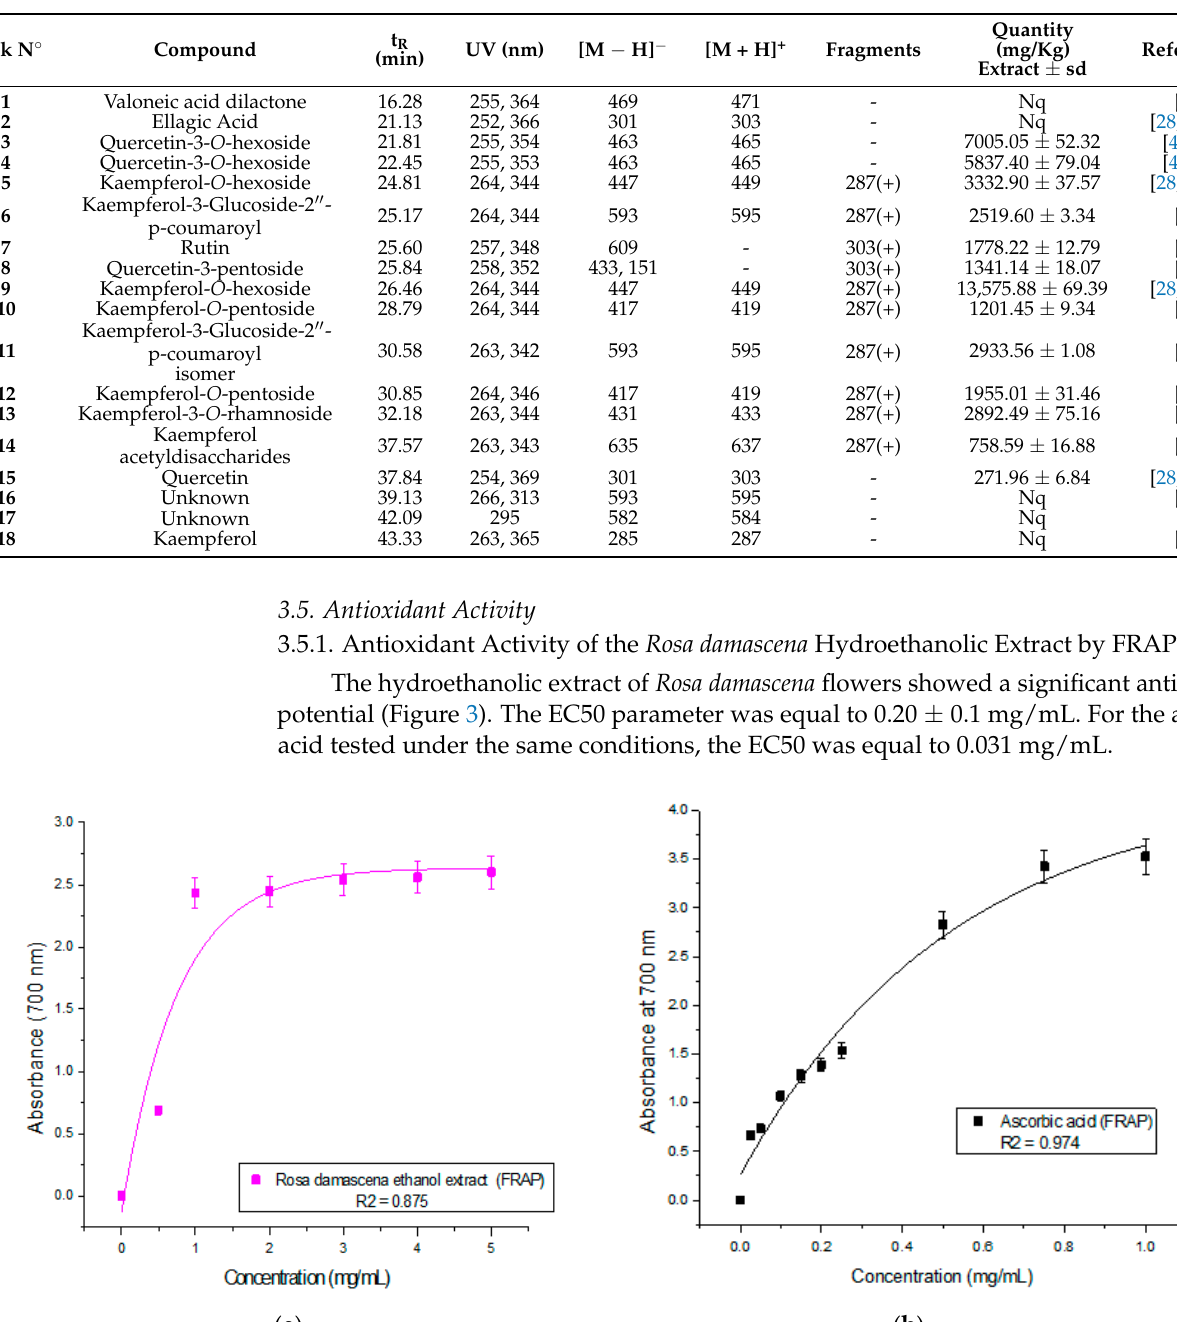
Table 2. Characterization of the phenolic compounds in the (EtOH:H 2 O 7:3 v / v ) extract of Rosa damascena by HPLC-PDA/MS.